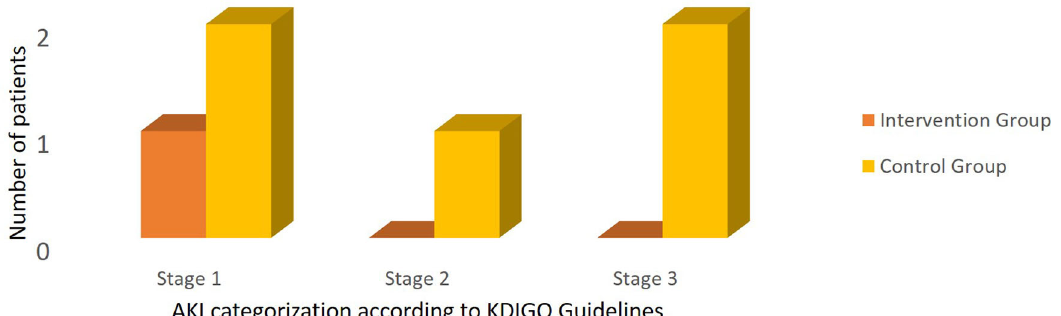
Figure 2. Acute kidney injury